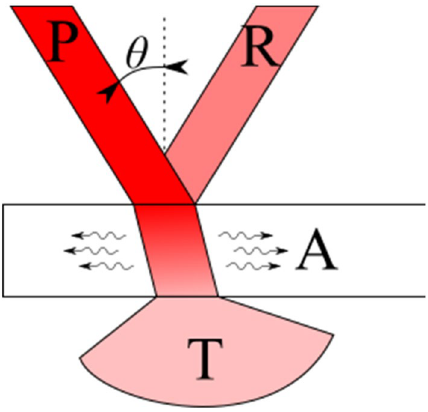
Figure 5. Reflection-transmission-absorption model of the interaction of light and solid